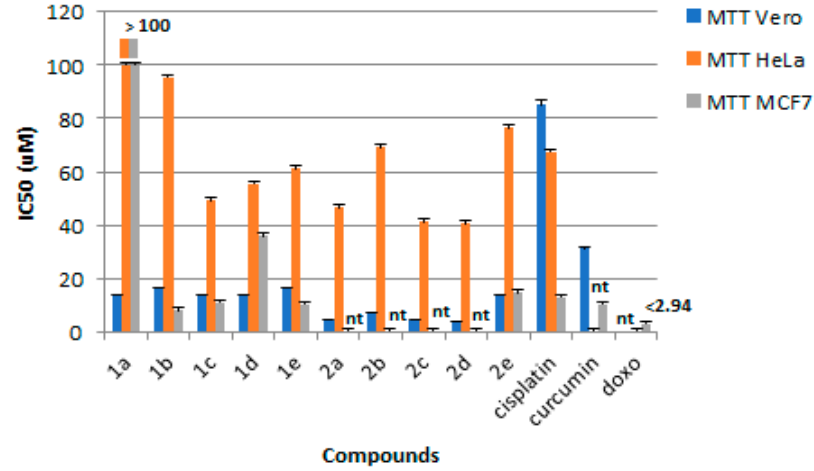
Figure 1. Cytotoxicity of the synthesized compounds against Vero, HeLa, and MCF7 Cell lines. nt = not tested.